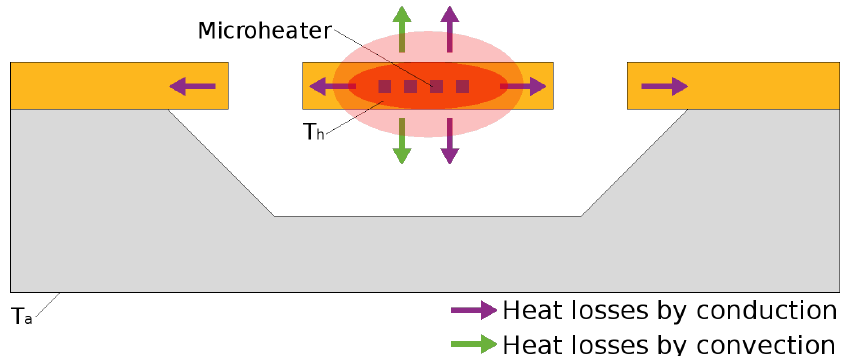
Figure 12. Heat loss mechanisms through the SMO gas sensor, where T h and T a correspond to the temperature of the microheater and the ambient temperature. The figure shows the locations of the principal heat losses of conduction, convection, and radiation which is represented by red